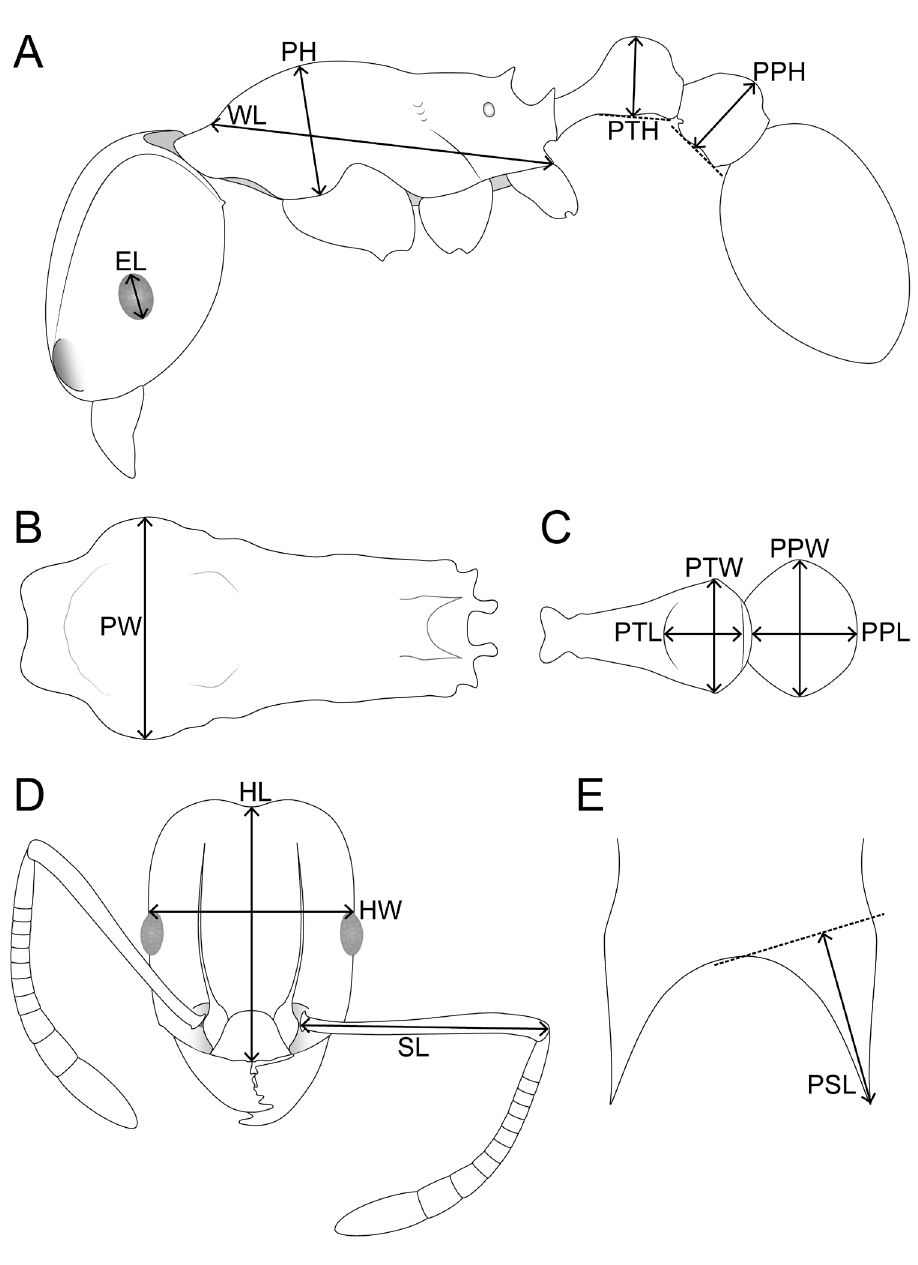
Figure 1. Schematic line drawings of Tetramorium cavernicola sp.n. illustrating the used measurements. A Body in profile with measuring lines for EL, WL, PH, PTH, and PPH B Mesosoma in dorsal view with measuring line for PW C Petiole and postpetiole in dorsal view with measuring lines for PTL, PTW, PPL, PPW D head in full-face view with measuring lines for HL, HW, and SL E Dorsocaudal view of the propodeum with measuring line for